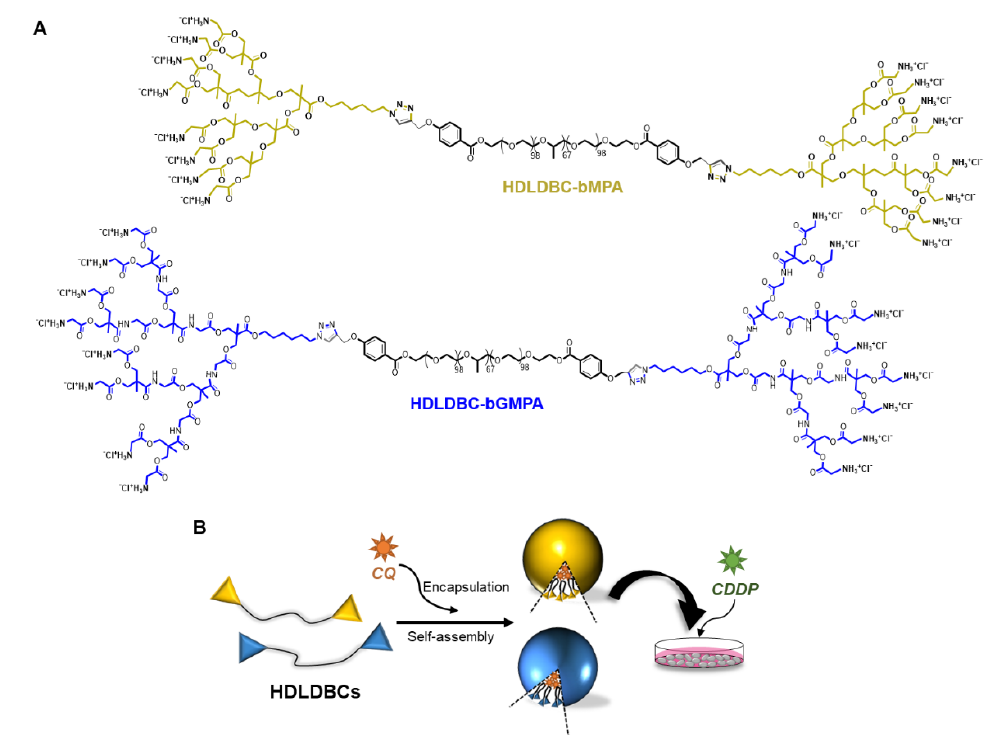
Figure 1. Representation of ( A ) chemical structures of the hybrid dendritic–linear–dendritic block copolymers (HDLDBCs) based on Pluronic ® F-127 and dendrons derived from 2, 2′ -bis(hydroxymethyl)propionic acid (bis-MPA) functionalized with glycine groups or 2, 2′ -bis(glycyloxymethyl)propionic acid (bis-GMPA). ( B ) Illustration of the structures obtained in the encapsulation of chloroquine (CQ) in the HDLDBC-bMPA (yellow) or HDLDBC-bGMPA (blue) for their use in vitro in combination with cisplatin (CDDP).